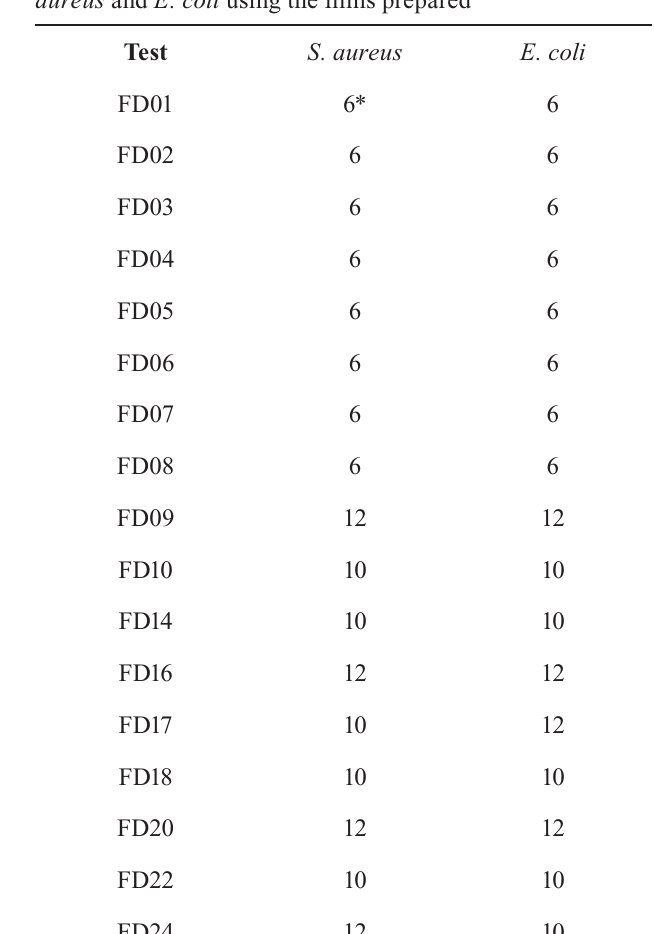
TABLE IV - Inhibition zone diameter (mm) obtained against